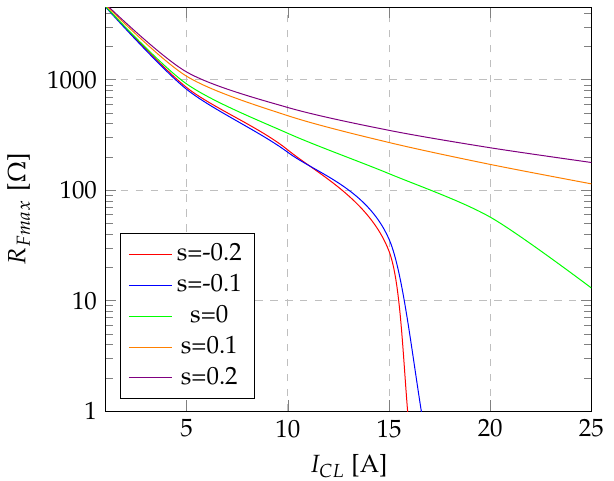
Figure 5. Maximum detected values of transition resistance R Fmax for the compensated network with a different value of the coefficient s